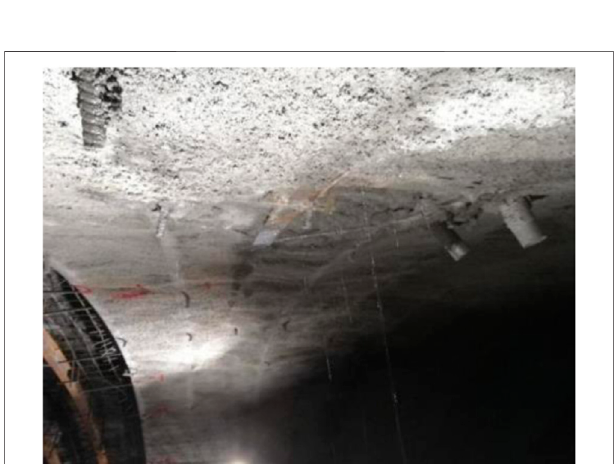
FIGURE 5 | Ranking results of risk factors ( X 5 – X 13 ) in the sensitivity analysis of tunnel collapse.